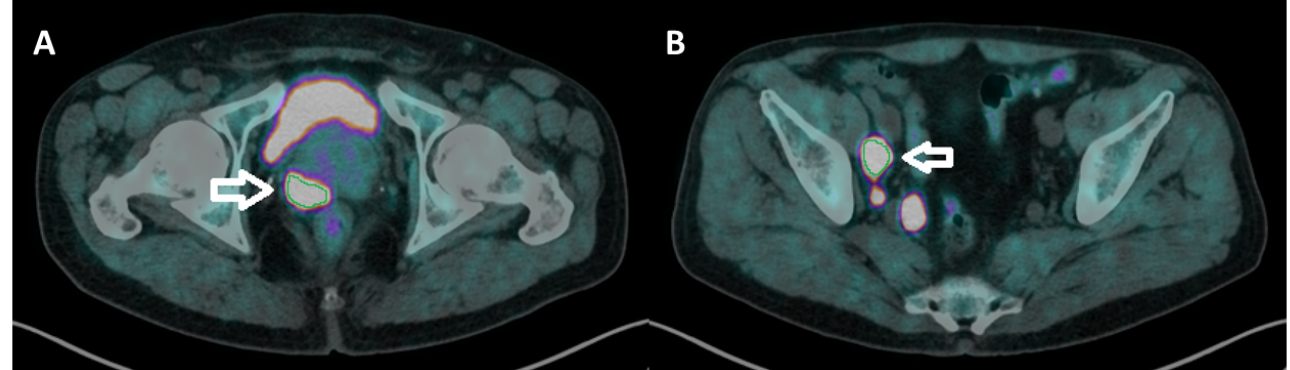
Figure 1. ( A , B transaxial fused images) manual workflow of [ 18 F]F-choline PET/CT imaging elabo- ration. A circular ROI was drawn on prostate cancer (( A ), white arrow) and lymph node metastasis (( B ), white arrow) and automatically adapted into a 3-dimensional VOI, from which the software directly extracted semiquantitative and volumetric (threshold = 40%) parameters.